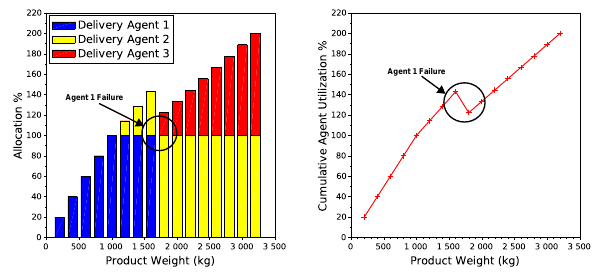
Figure 9. Allocation Ratio with Agent Failure. coordinating multiple robots deployed on the shop